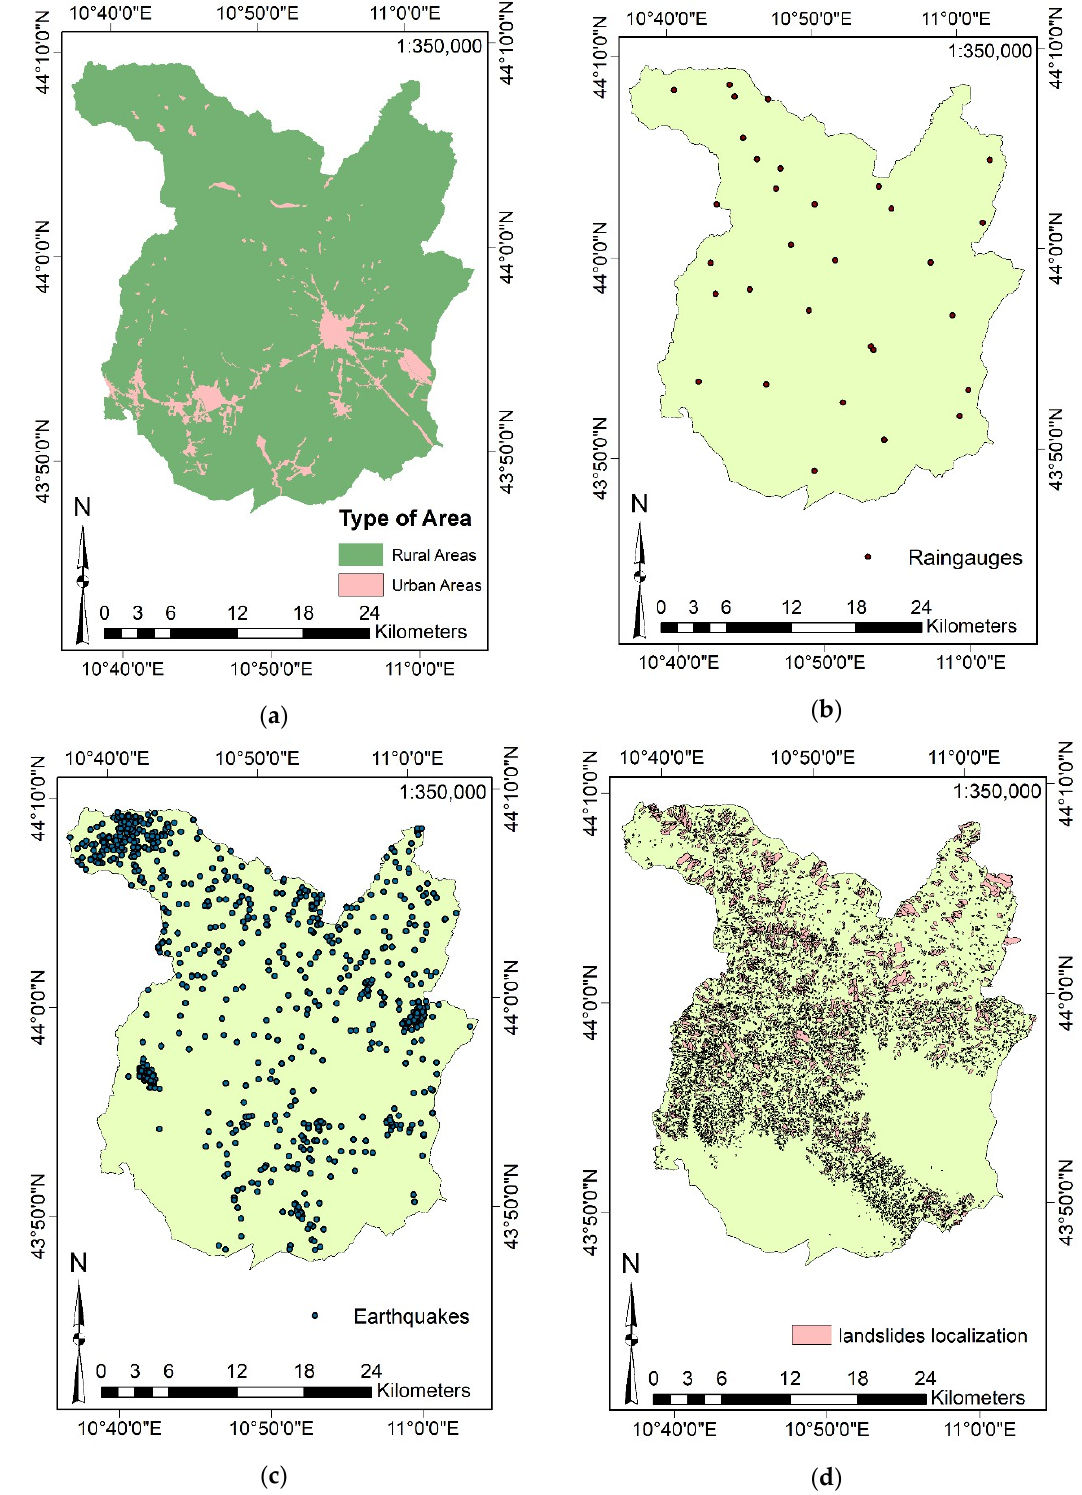
Figure A2. Information collected: ( a ) Type of Area (Urban or Rural according to the Italian Road Design standards [ref]); ( b ) rain gauge stations; ( c ) earthquakes occurred; ( d ) landslides occurred.